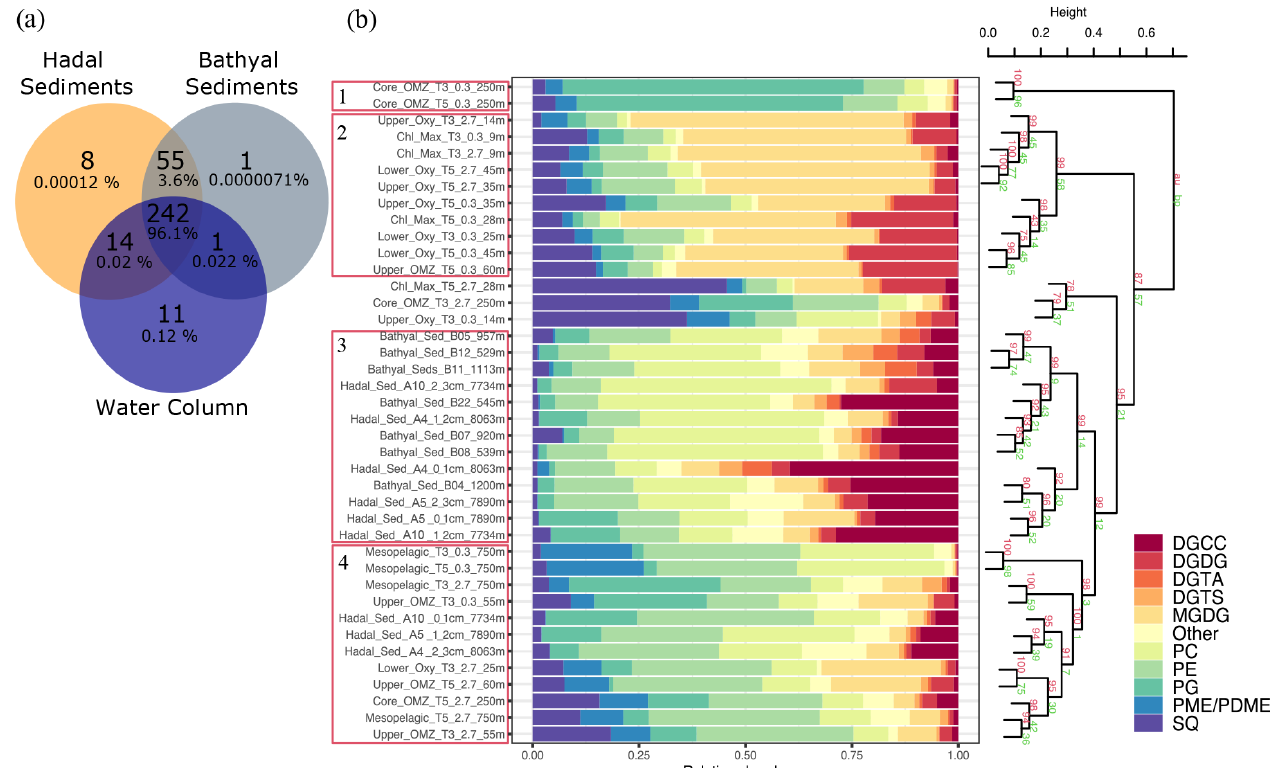
Figure 6. Comparison of IPLs in bathyal and hadal sediments (this study) and the overlying water column (Cantarero et al., 2020). (a) Venn diagram showing the number and percentage of unique and shared IPL molecules between these three environments. (b) Cumulative bar charts of IPL fractional abundances in each sample. Samples were grouped according to arithmetic mean (UPGMA) hierarchical clustering based on Euclidean distances. The cluster analysis on the right-hand side shows approximately unbiased (AU) and bootstrap probability (BP) in red and green numbers, respectively, whereas p values are shown at branching points. Clusters with AU ≥ 95% confidence are highlighted in red on the left-hand